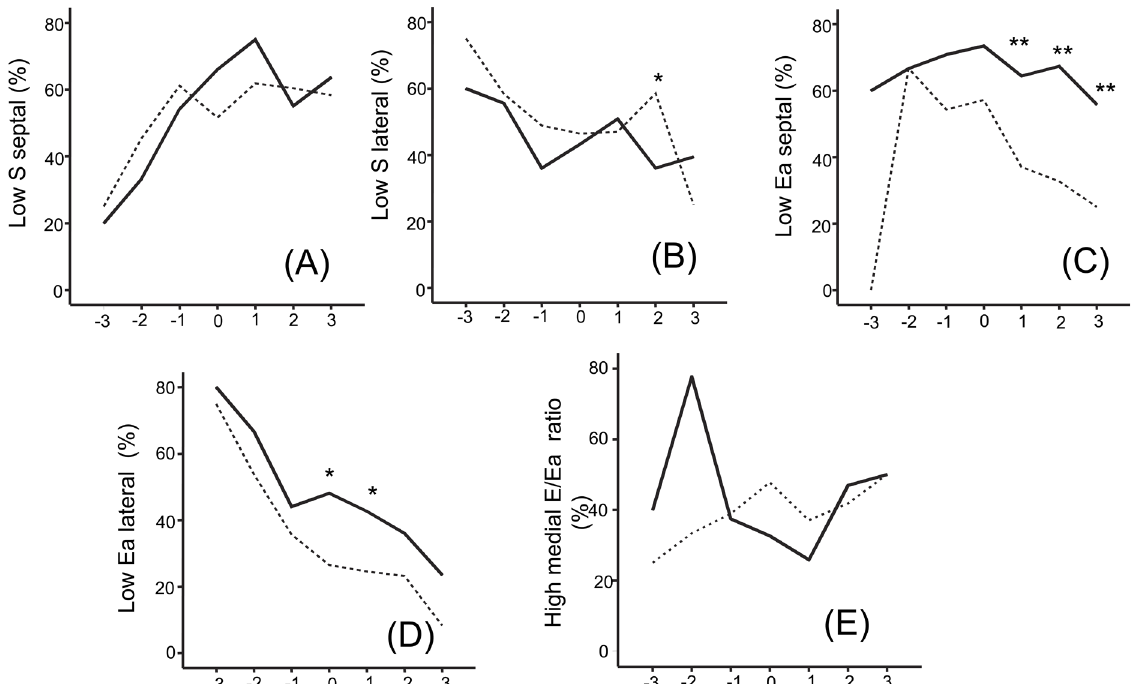
Fig 4. Frequencies of abnormal TDI during the course of the illness. Percentages of DF (dotted lines) and DHF cases (solid lines) with low septal and lateral S wave (A, B) and septal and lateral Ea wave (C, D) and high E/Ea ratios (E) determined based on published age-specific normal values (21). * different from DF ( P < .05).